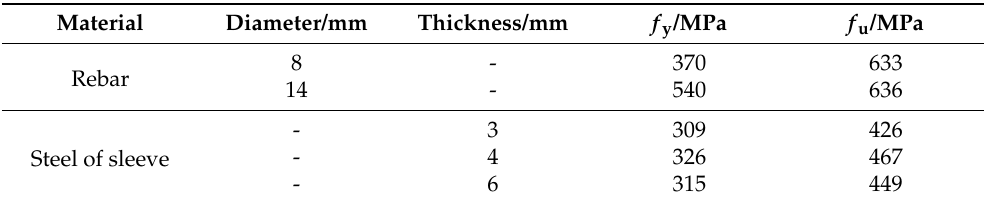
Table 2. Mechanical parameters of rebars and